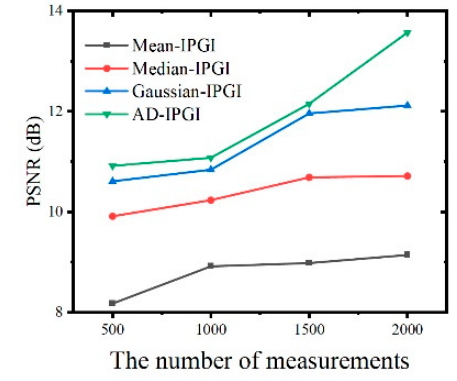
Figure 9. The peak signal-to-noise ratio (PSNR) curves of the imaging object “Slits” for Mean-IPGI, Median-IPGI, Gaussian-IPGI and AD-IPGI, for 500, 1000, 1500 and 2000 measurements.